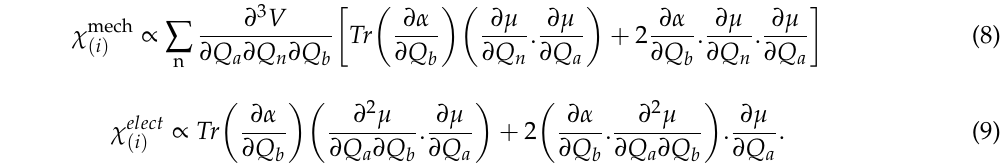
Supplementary Materials: The following are available online, Figure S1: Calculated IR and Raman spectrum for each species in enamine reaction pathway. Figure S2: Calculated IR and Raman spectrum for each species in imine reaction